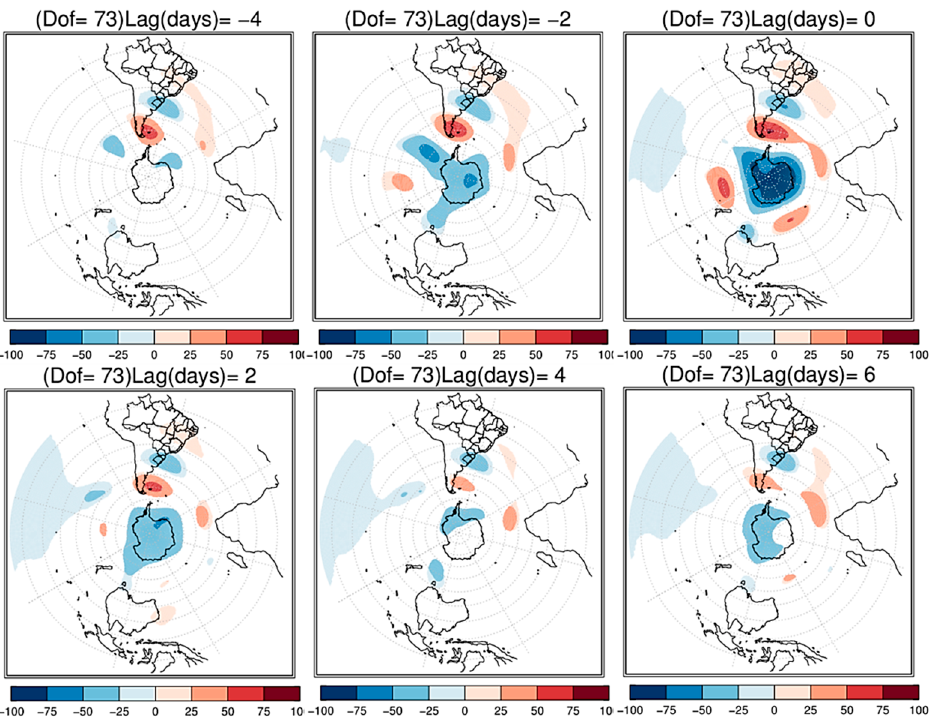
Figure 13. The same as Figure 10 but at 200 hPa.